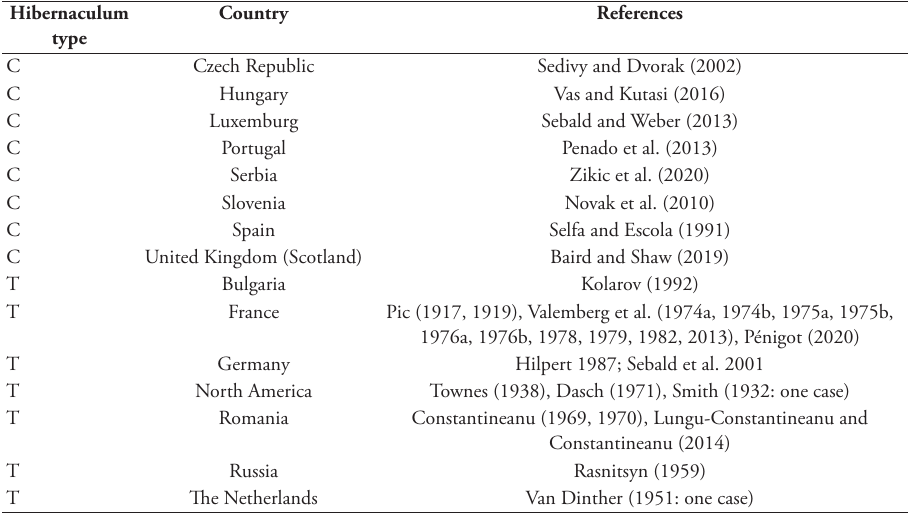
Table 2. Past research on particular hibernaculum type and